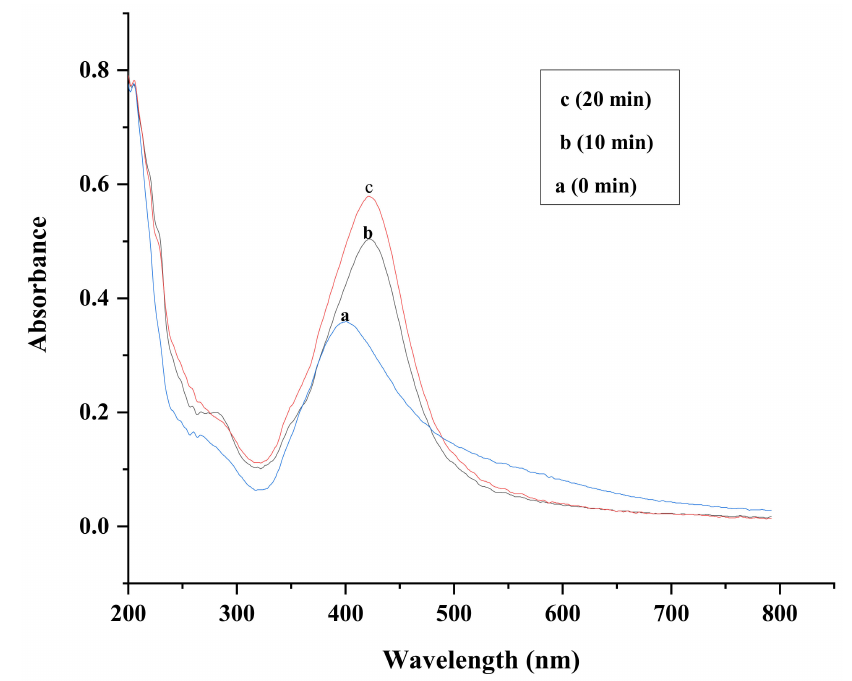
Figure 2. UV-Vis spectra of silver nanoparticles at different intervals of time.